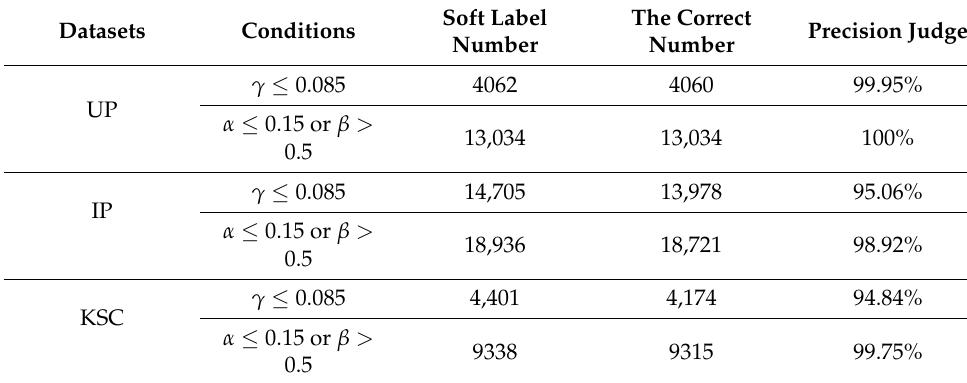
Table 4. Use two judgment methods to generate soft label results.